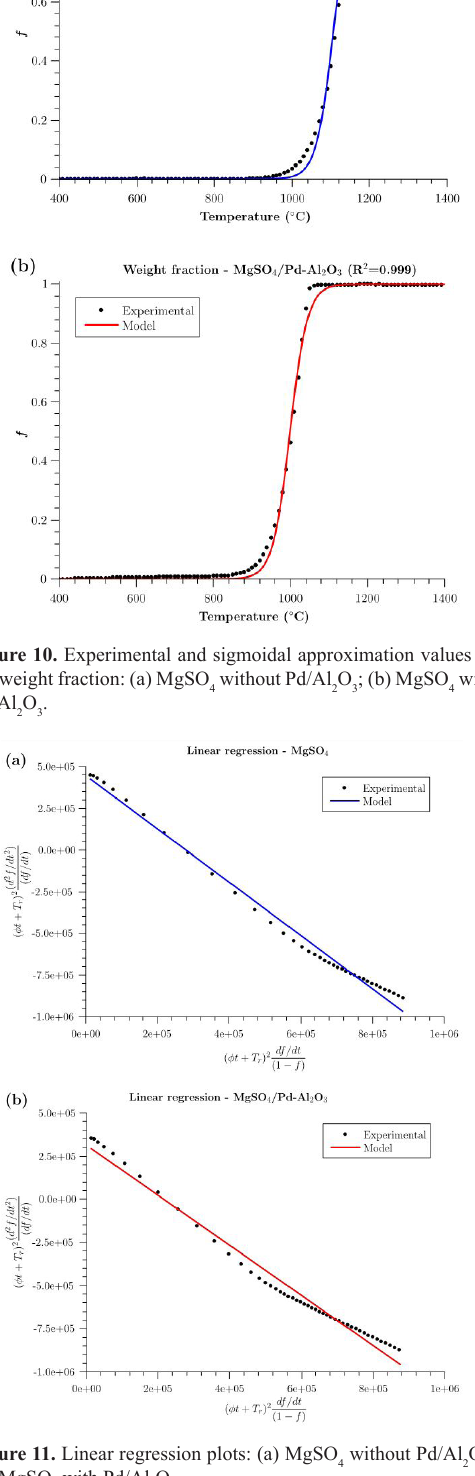
without Pd/Al O ; 4 2 3